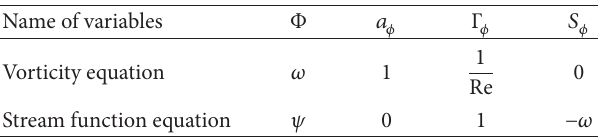
Table 3: Parameters of equations for vorticity-stream function algorithm of lid-driven flow.